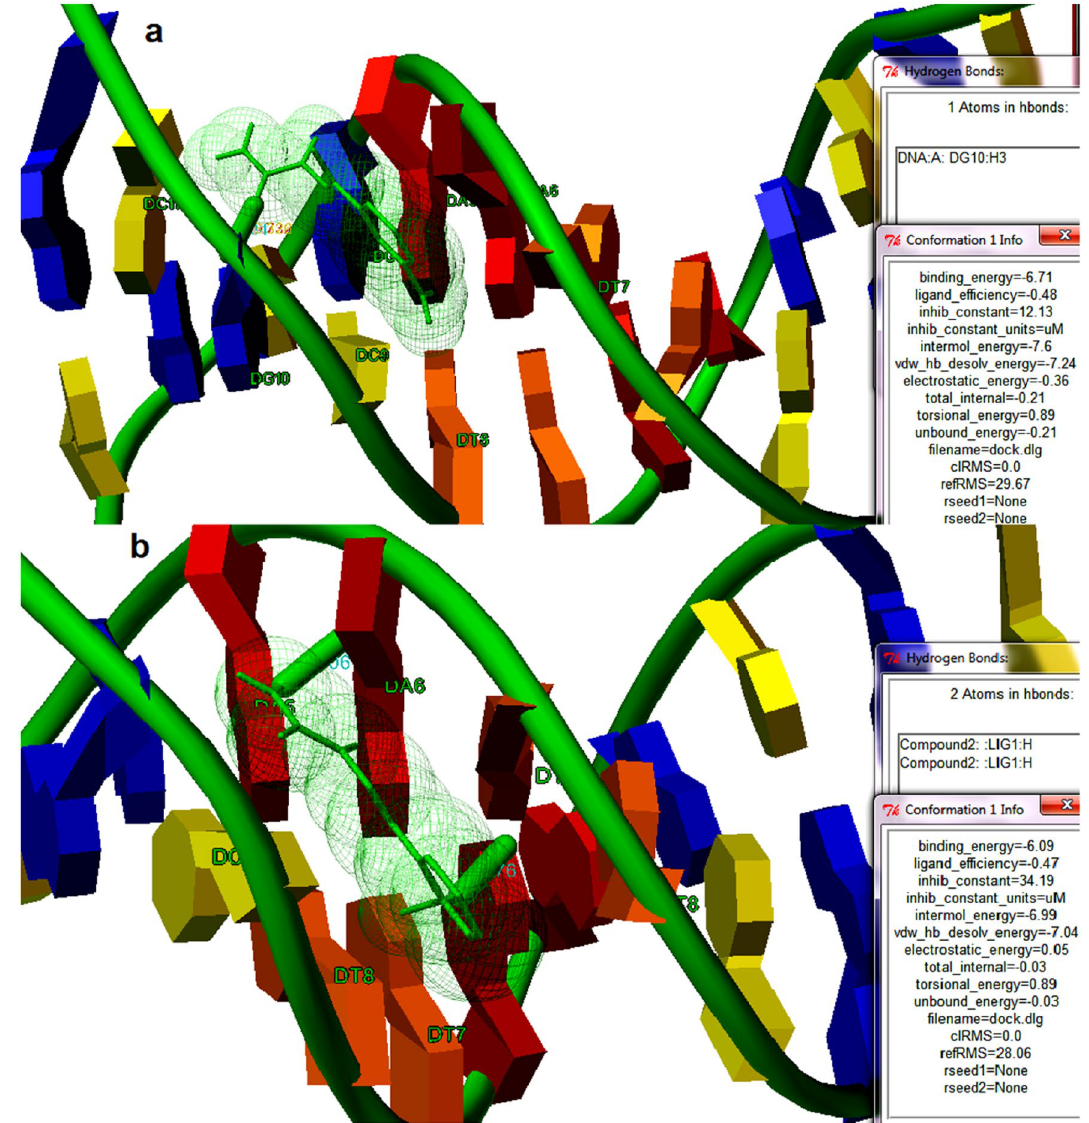
Figure 7. The binding potential of compounds 1 and 2 towards CT-DNA (PDB ID: 2DYW) is modeled by molecular docking. ( a ) The best binding conformation of (E)-2-(2-aminobenzylidene) hydrazinecarboxamide and DNA predicted by molecular docking with the binding energy of − 6.71 kcal/mol is shown in the figure. The ligand is highlighted in green colored stick figures and teh DNA is also shown. A thick green colored stick indicates hydrogen bonding. The residues present in the binding cavity of the DNA are also highlighted ( b ) The best binding conformation of (E)-2-(2-aminobenzylidene) hydrazinecarboxamide and DNA with the binding energy of − 6.09 kcal/mol are shown in the figure. The binding energy (kcal/mol), ligand efficiency, inhibition constants (µM), intermolecular energies are also shown in both the